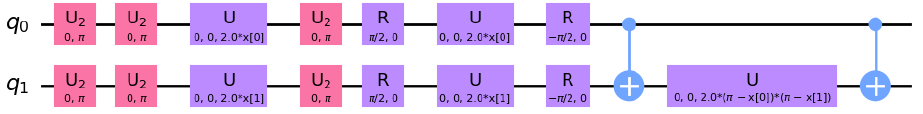
Figure 6. Schematic diagram of the analog circuit of PauliFeatureMap.